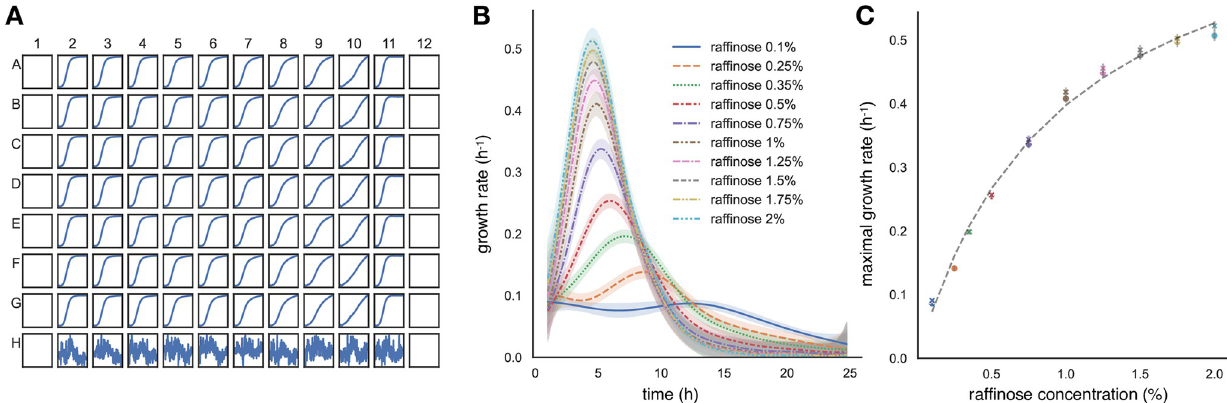
Fig 1. Using omniplate , it is straightforward to simultaneously analyse data from multiple wells in the same plate and from multiple plates. A An overview of the measurements of OD in each well of an experiment investigating growth of budding yeast in the sugar raffinose. Wells at the edge of the plate have been left empty because the media in these wells can evaporate more than others, at least for our plate reader. The OD measured in each well is plotted as a function of time. We used the wells in the last row for normalisation. They contain only media and have a different scale on the y -axis. B omniplate estimates growth rate as a function of time using a Gaussian process [17]. To determine yeast’s growth rate in different concentrations of raffinose, data from two plates with seven replicates for each raffinose concentration per plate was combined. Each concentration is present in both plates except for 0.25% and 0.35% raffinose. We show the average for the two plates of the mean growth rate inferred from all the relevant wells in each plate. Data from the first hour of the experiments was not used to estimate growth rates because of fluctuations in the measured OD. Shaded errors are standard deviations. C Yeast’s growth in raffinose obeys Monod’s equation (dashed line) with a best-fit K of 1.0% (20 mM); the best-fit corresponding growth-rate S parameter is 0.82 h − 1 . The local maximal growth rate for each concentration for each plate is shown.